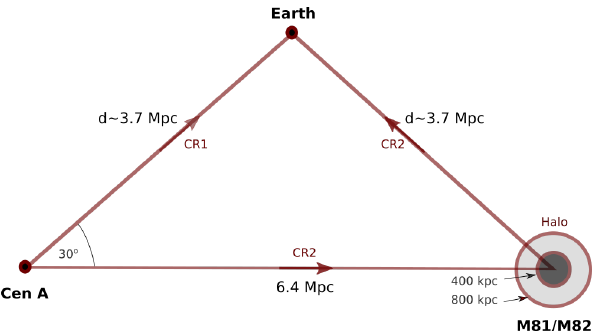
Figure 5. Sketch of the echo model in which UHECRs, originally being accelerated in Cen A, are scattered and reflected in the spherical halo of the starburst galaxy M82 (with radius up to 800 kpc), introducing an apparent UHECR—starburst galaxy correlation. In this scenario, UHECRs arriving at Earth via M82 (CR2) are delayed by approximately 20 Myr relative to those arriving by direct propagation (CR1) from Cen A. After ref.